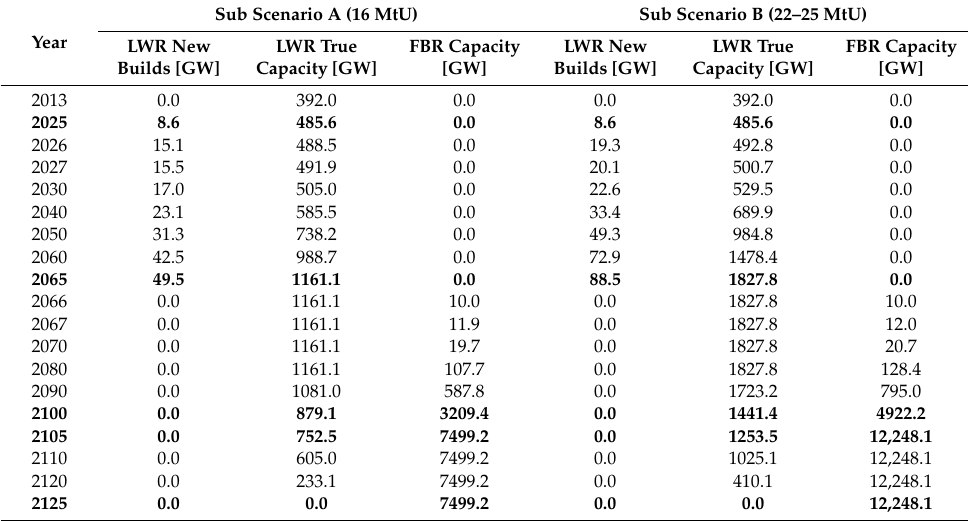
Table 8. Proposed dynamics of LWR / FBR buildup for scenario S2.